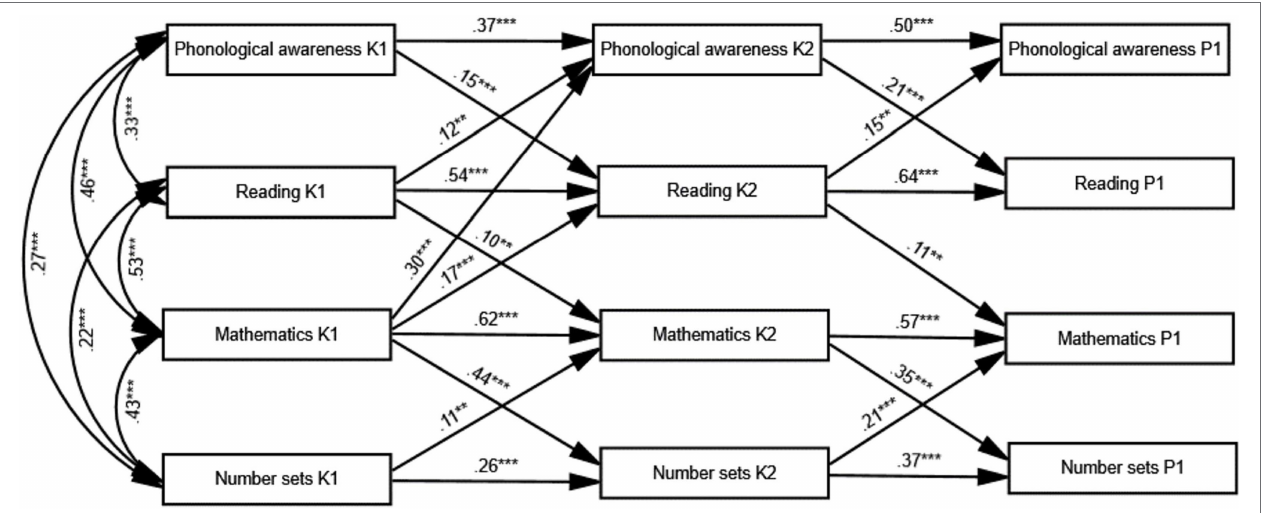
FIGURE 1 | Path model with parameter estimates that only significant path is shown in the diagram. For clarity, paths from covariates (SES, age, and non-verbal ability) and residual co-variances are not shown. * p <0 .01 and *** p <0